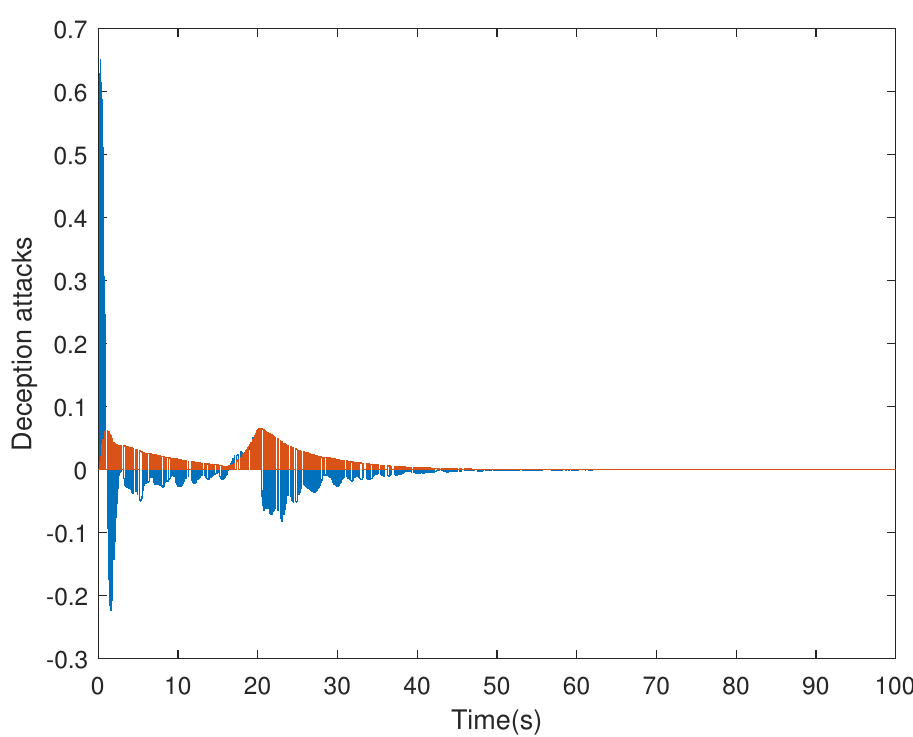
Figure 5. Deception attacks with ¯ ϕ =